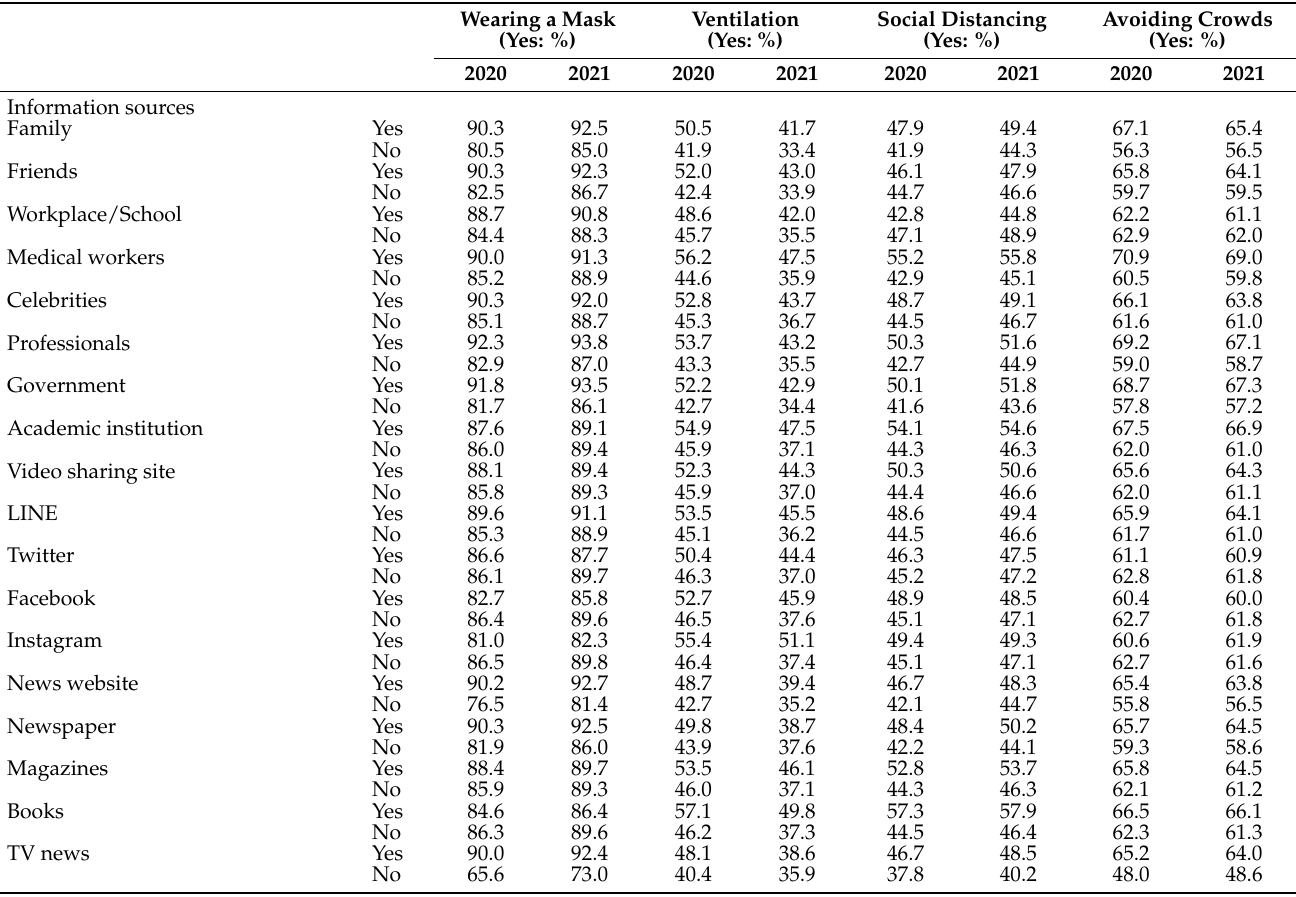
Table 2. The compliance with preventive behaviors for COVID-19 based on the characteristics in 2020 and 2021 ( n =